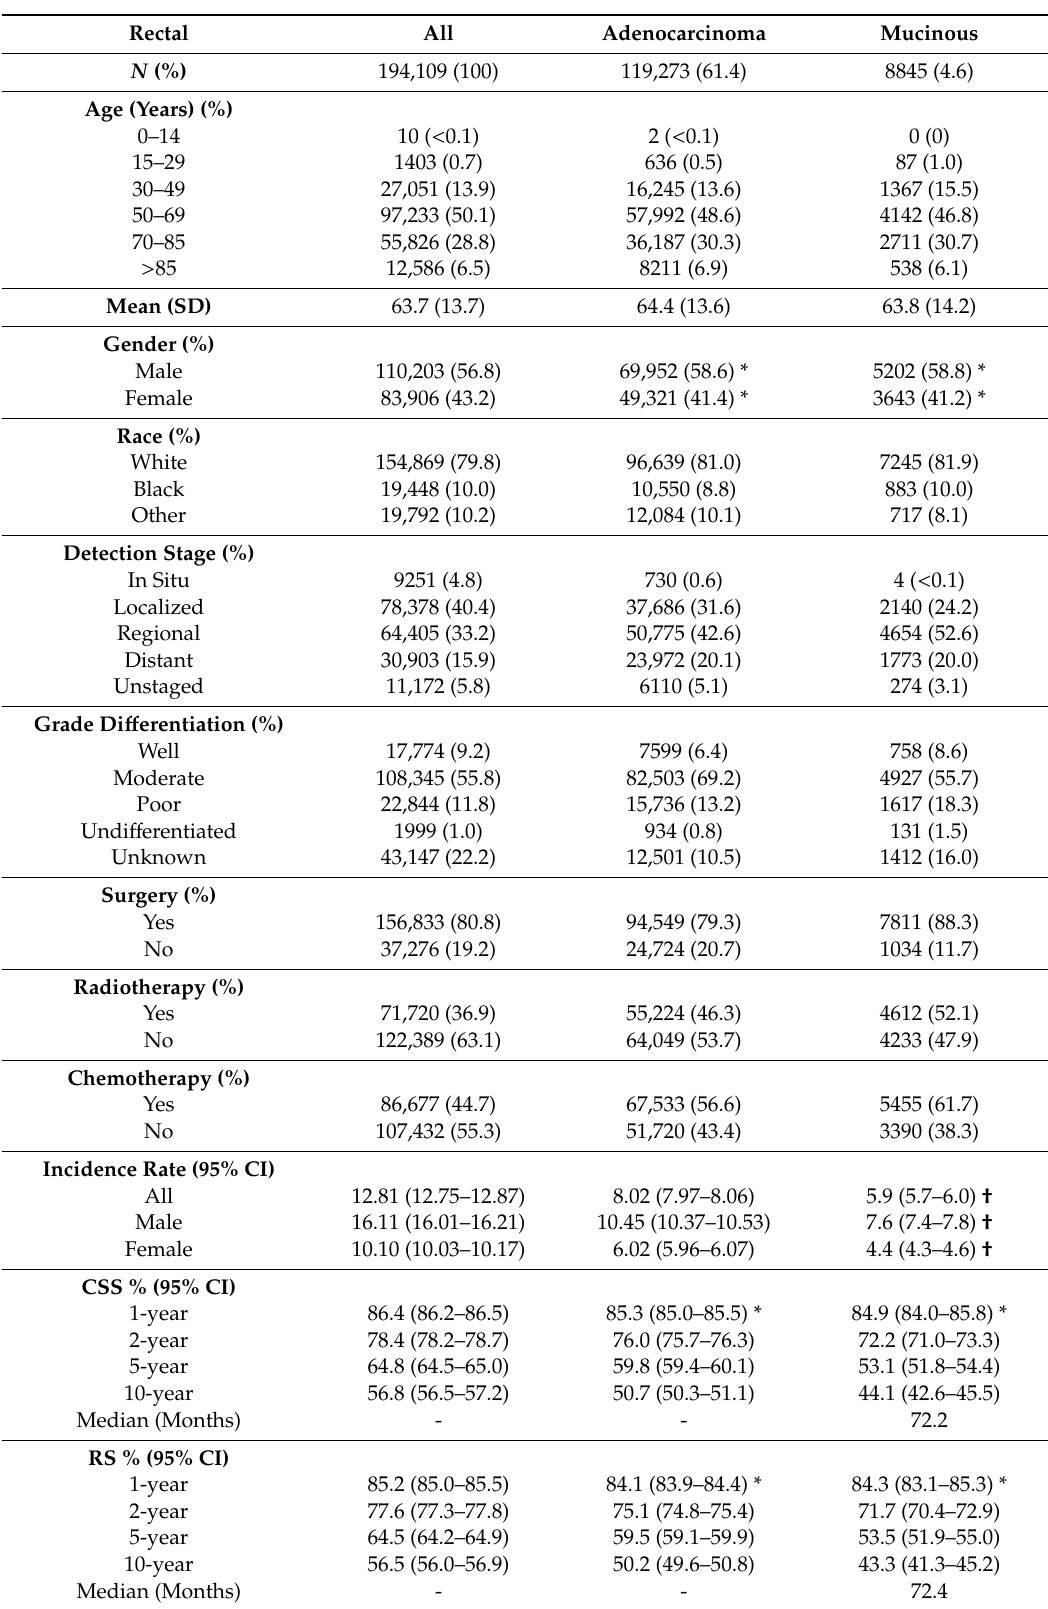
Table 7. Baseline demographics and clinical characteristics by histology for rectal